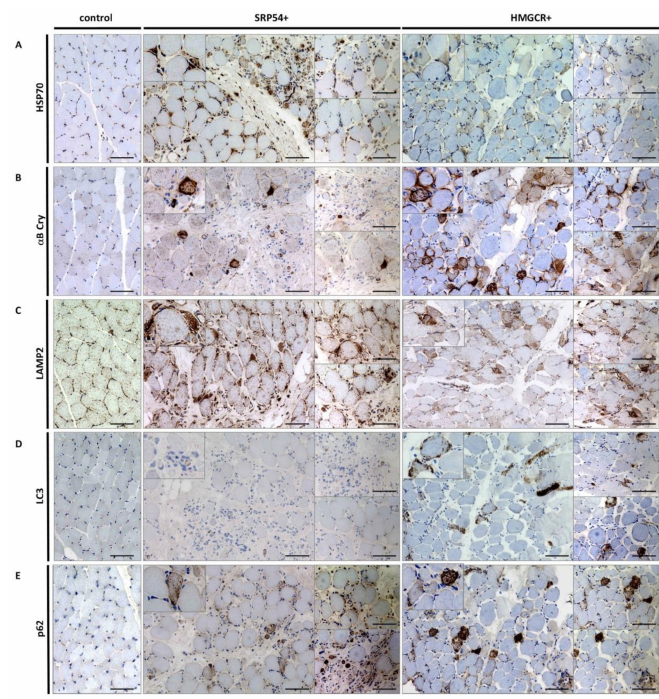
Figure 5. Histological findings in both juvenile IMNM patients with focus on the protein clearance machinery. Histological staining of markers involved in proteostasis showed upregulation of all investigated proteins in both juvenile IMNM patients, with subtle differences in staining